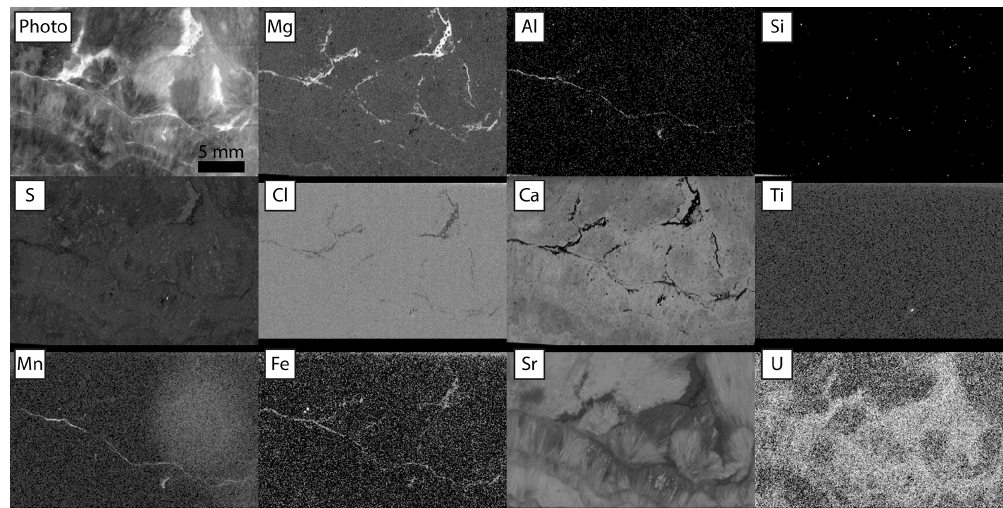
Figure 4. Relative intensities of emission regions for each element detected in Walnut Canyon, imaged at 20µm pixels with 1.5SD Gaussian blur. Dwell time was 30ms per pixel for maps with no incident radiation filter (Mg, Al, Si, S, Ca). Dwell time was 60ms per pixel for maps with incident radiation filtered with 100µm Al, 50µm Ti, 20µm Cu foil (Cl, Ti, Mn, Fe, Sr, U). Each panel is adjusted in terms of gamma and contrast to emphasize gradients between